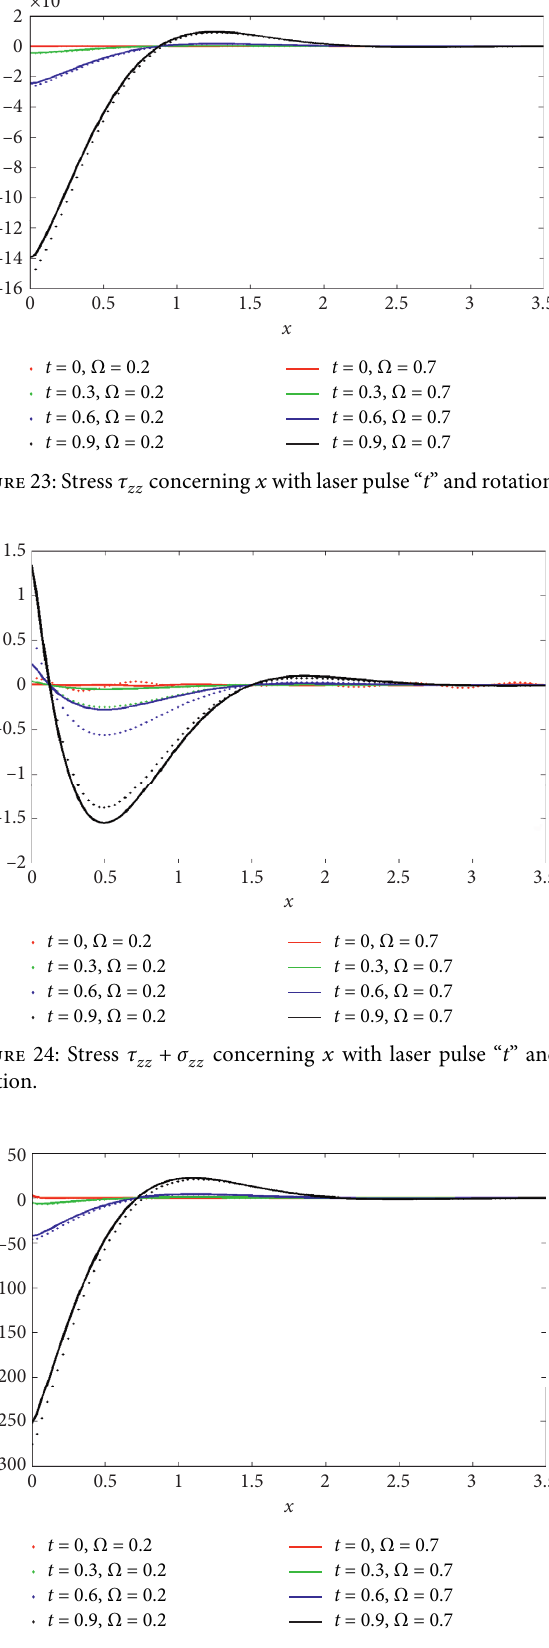
Figure 25: Temperature T concerning x with laser pulse “ t ” and rotation.